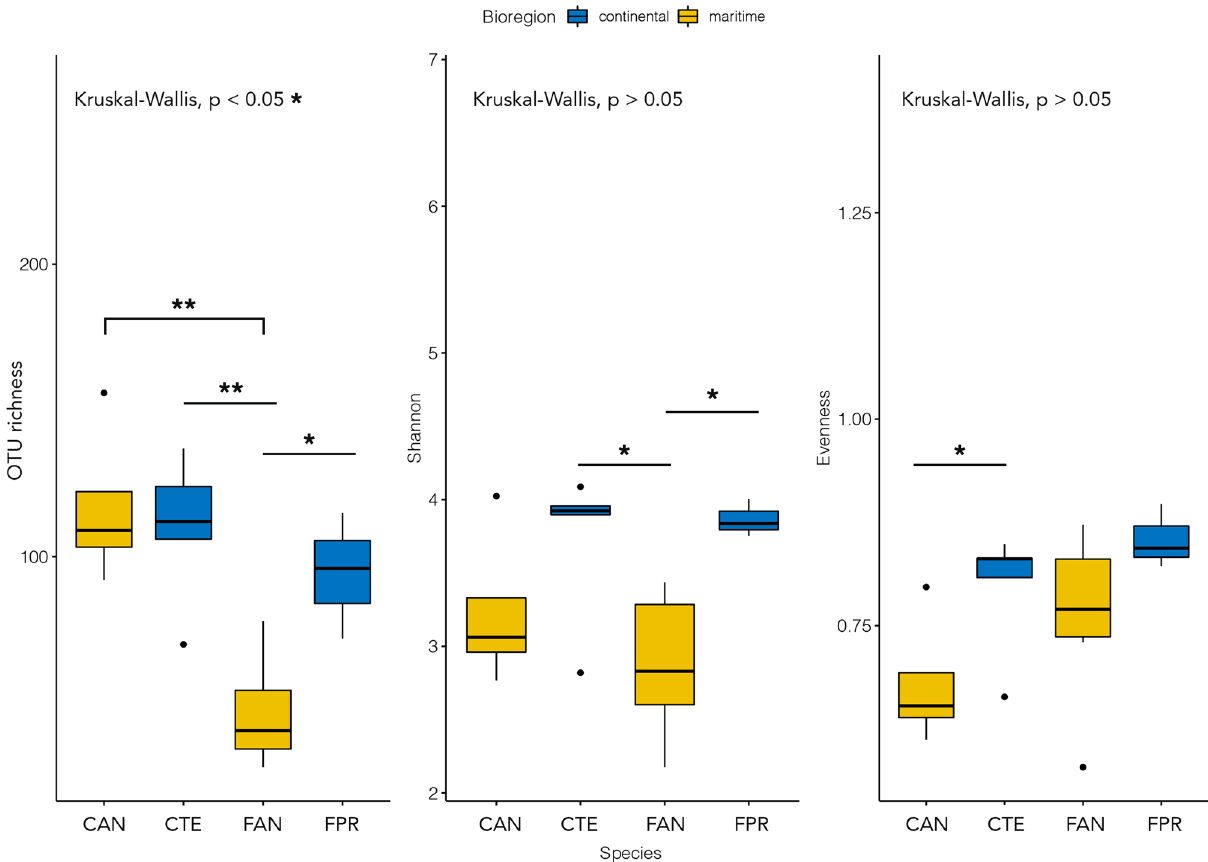
Figure 2. Alpha diversity: observed OTU richness, Shannon and Evenness indexes. The P value of the Kruskal– Wallis test is shown at the top of each plot; lines and asterisks highlight significant differences observed after pairwise Mann–Whitney–Wilcoxon tests. *P < 0.05; **P < 0.01. Blue and yellow colours indicate species collected in the continental and maritime Antarctic regions, respectively. The figure was generated using the R package ggplot2 v3.2.1 (https ://ggplo t2.tidyv